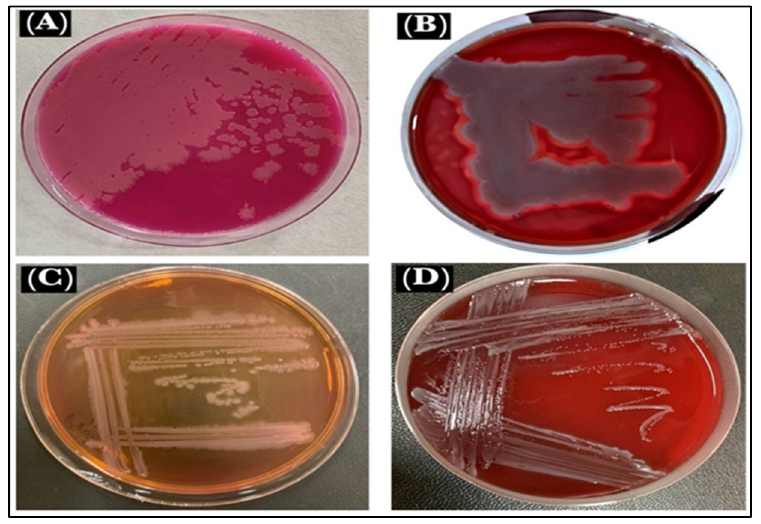
Figure 8. Microbe views: ( A ). B. cereus on MYP, ( B ). B. cereus on blood agar, ( C ). P. mirabilis on MacConkey agar, and ( D ). P. mirabilis on blood agar.